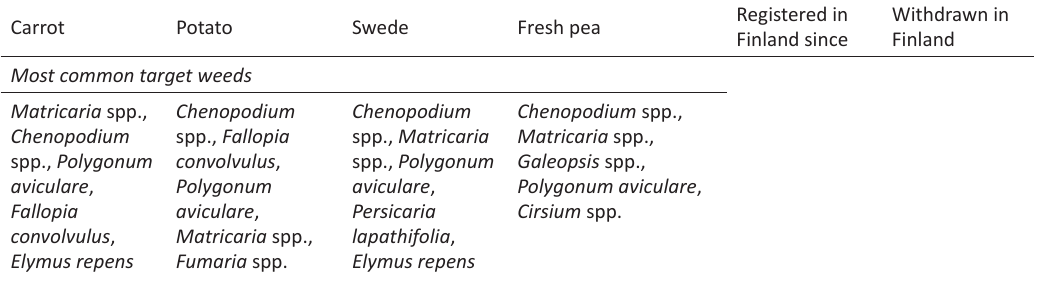
Table 2. The most common weeds (Natural Resources Institute Finland 2021c) and the herbicides used for control in carrot, potato, swede and fresh pea crops (the database of Apetit Ruoka Ltd.), the year of registration and withdrawal from the Finnish market, and derogations of non-registered PPPs (Finnish Safety and Chemicals Agency 2021c). The substances are arranged according to their selectivity, such that the first ones are the least selective and the last the most selective